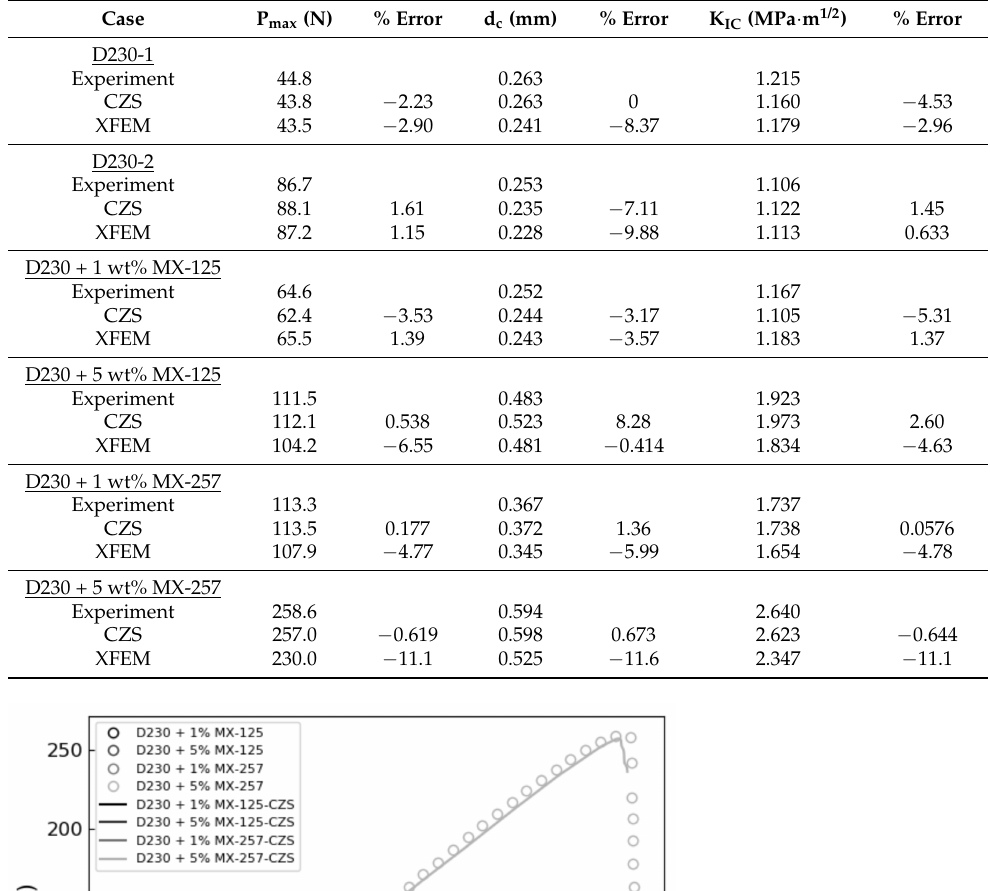
Table 6. Fracture properties for each epoxy resin. K IC was calculated according to Equation (1). Percent error was calculated for the predicted model relative to the experimental results.